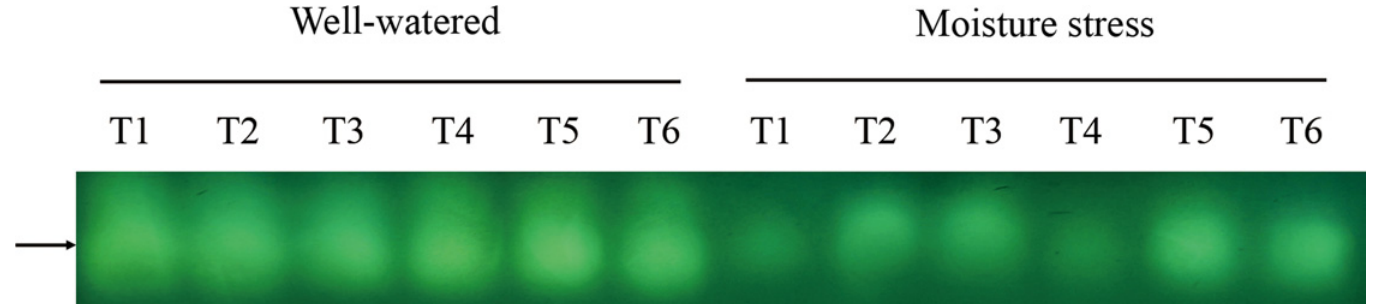
Fig 8. Native gel stained for the activity of CAT isoform of drought stressed creeping bentgrass treated with cytokinin trans -zeatin riboside (CK) and nitrogen. T1 to T6 represent low N + CK0, low N + CK100, low N + CK10, high N + CK0, high N + CK100, high N + CK10 of creeping bentgrass at 40 d,